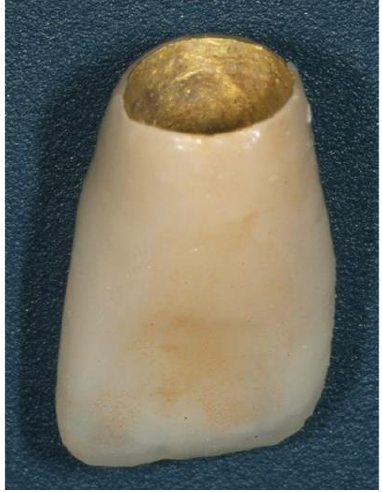
Figure 3. Cement-retained Auro-Galvan Crown (AGC).